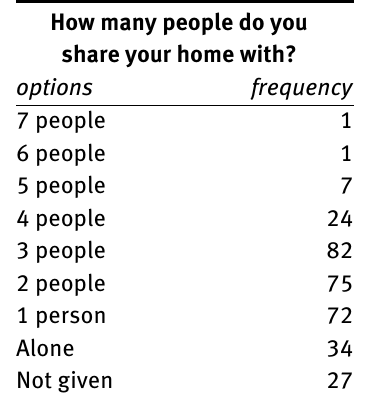
Table 5: Frequency distribution of the number of flatmates the subjects share the dwelling